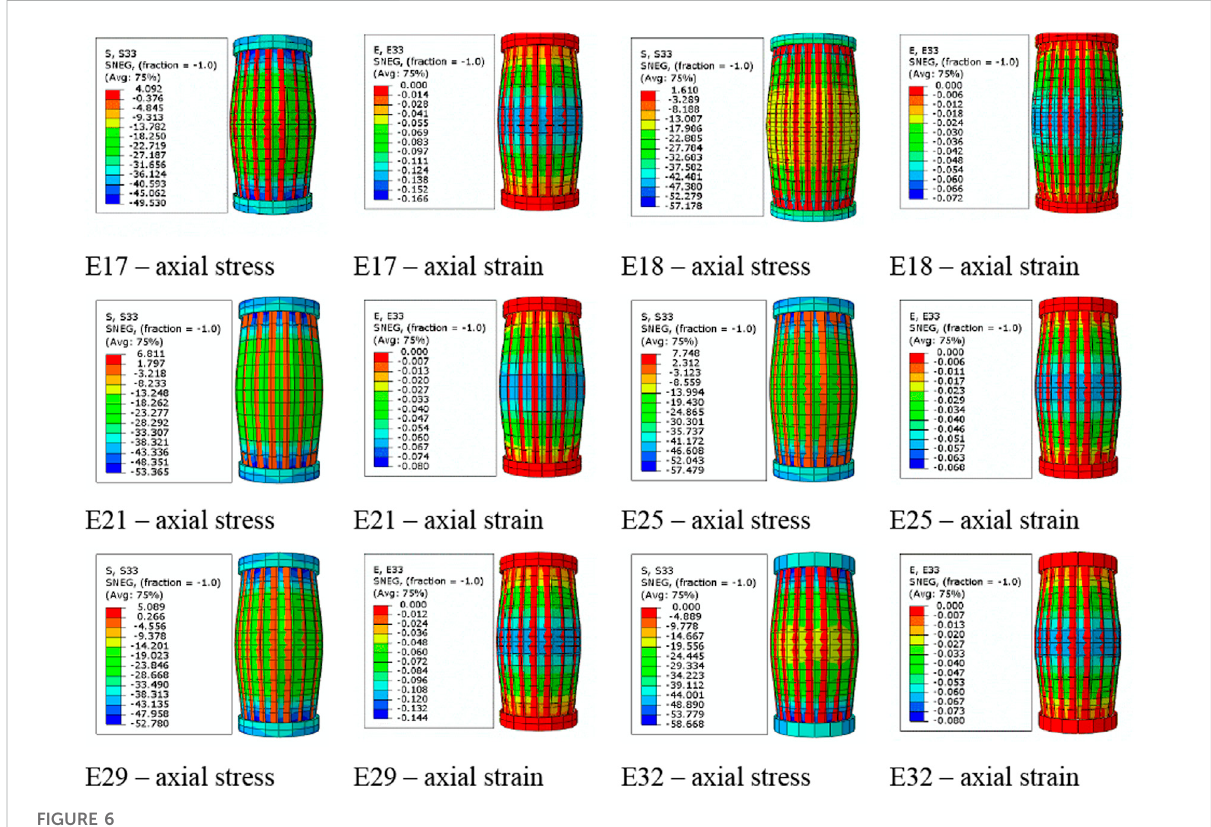
FIGURE 6 Simulated axial stress and axial strain for Woldemariam et al.